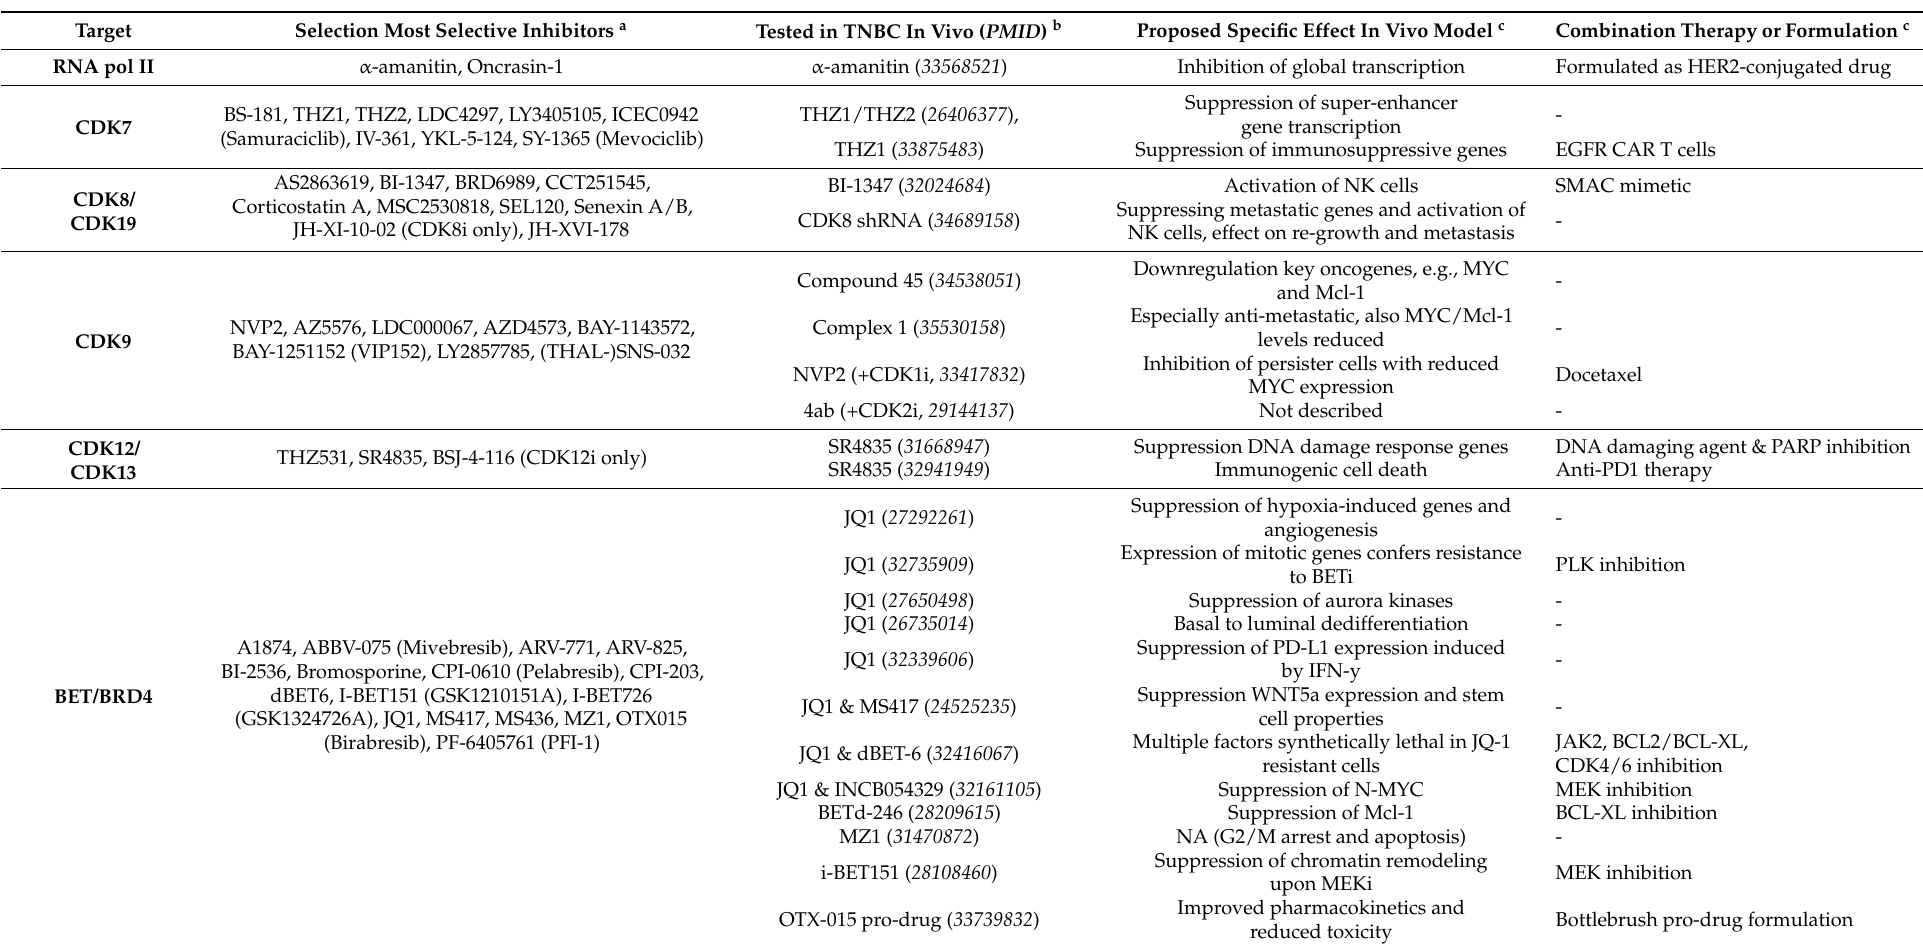
Table 1. Overview inhibitors of the TM and their proof-of-concept in TNBC in vivo